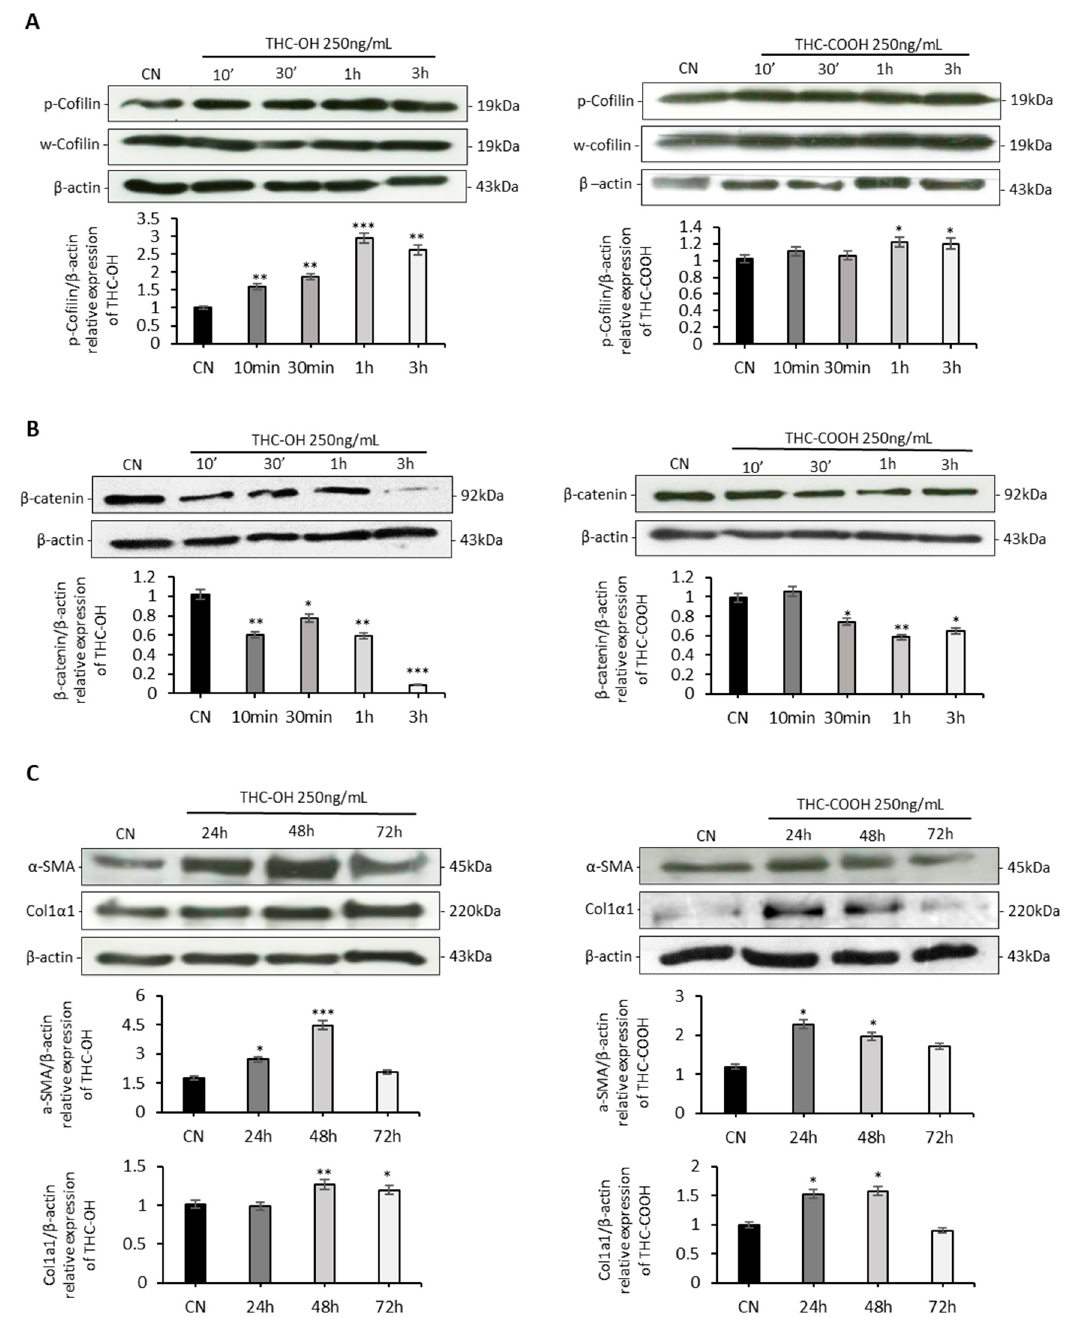
Figure 4. Cannabinoids differentially modulate ABP and ECM proteins . ( A ) Immunoblot analysis of Cofilin phosphorylation following THC-OH and THC-COOH exposure in H9c2 cardiomyocytes. ( B ) Time dependent protein detection of β -catenin following THC-OH and THC-COOH. ( C ) Western blot analysis of α -SMA and Col1 α 1 following THC-OH and THC-COOH. ( A – C ) Representative immunoblots of three independent experiments. Drug treatment concentration for both THC-OH and THC-COOH were 250 ng/mL. Densitometry indicating relative band expression for each blot measured using ImageJ software. Statistical comparison for treated vs. control was performed by a two-tailed Students unpaired t - test (* p < 0.05, * p < 0.01 and *** p < 0.001) for individual time points.